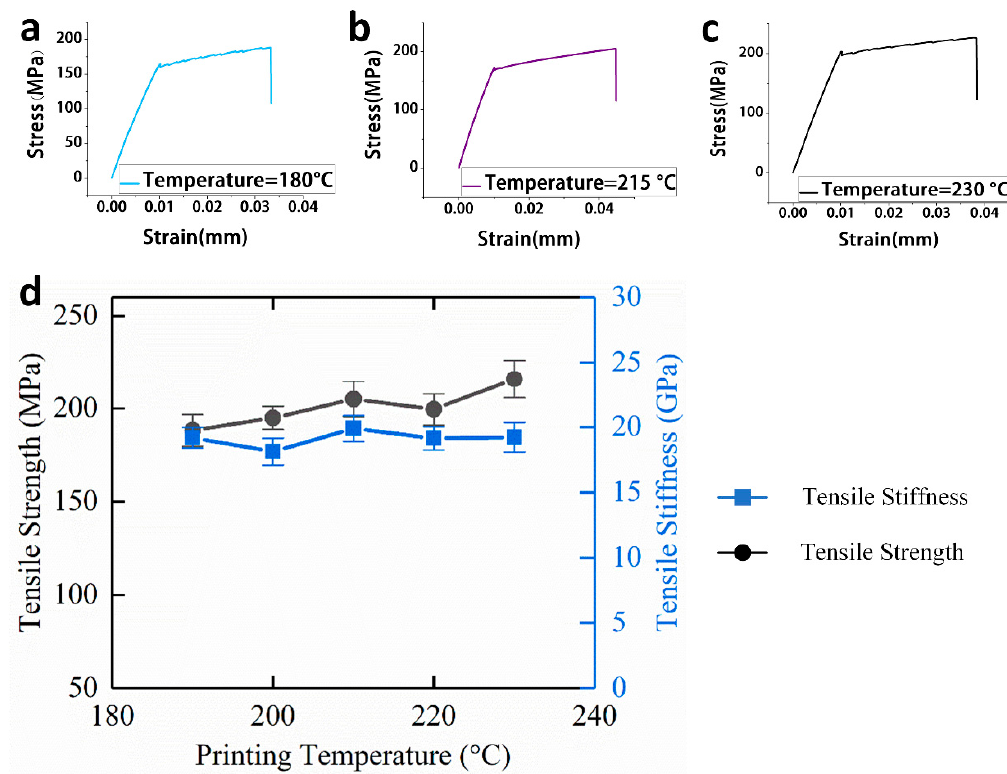
Figure 10. ( a ) Tensile stress-strain curve of specimens while the printing temperature is 180 °C; ( b ) Tensile stress-strain curve of specimens while the printing temperature is 215 °C; ( c ) Tensile stress-strain curve of specimens while the printing temperature is 230 °C; ( d ) Effect of printing temperature on tensile mechanical properties of continuous carbon fiber-reinforced 3D printing.